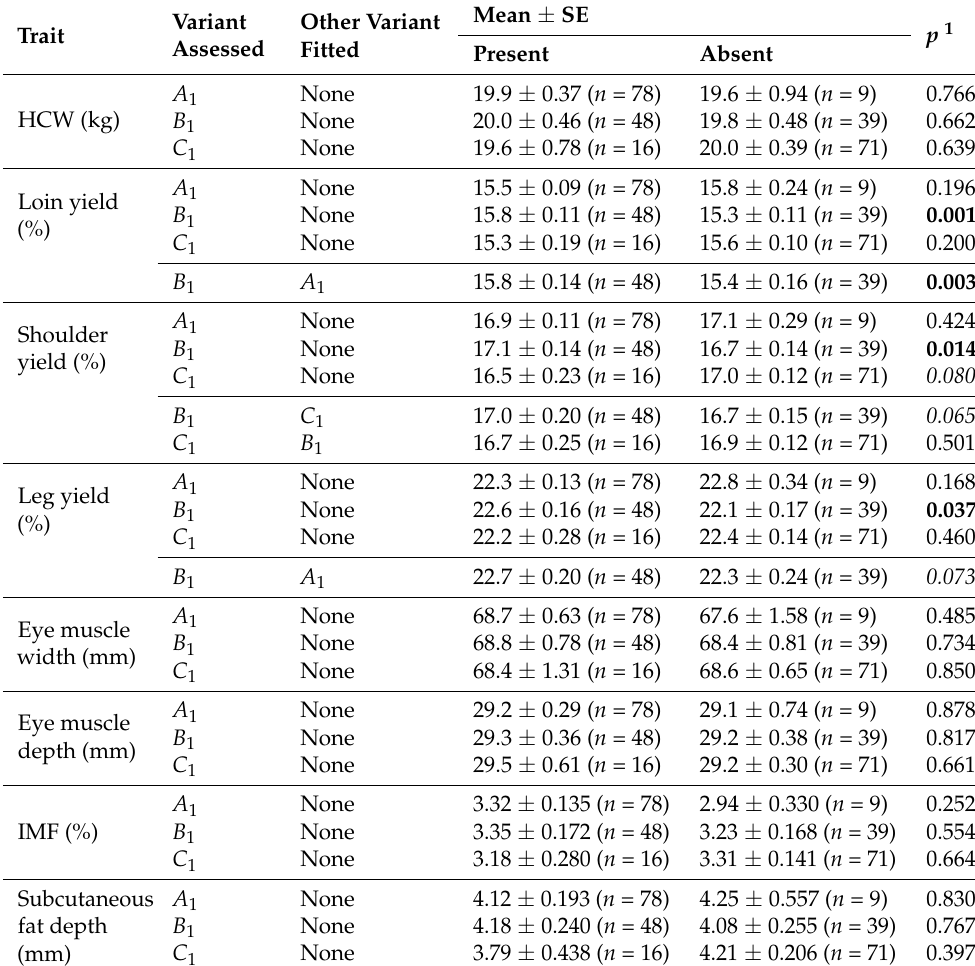
Table 2. Association between the presence or absence of DGAT1 intron 1 variants and carcass traits.